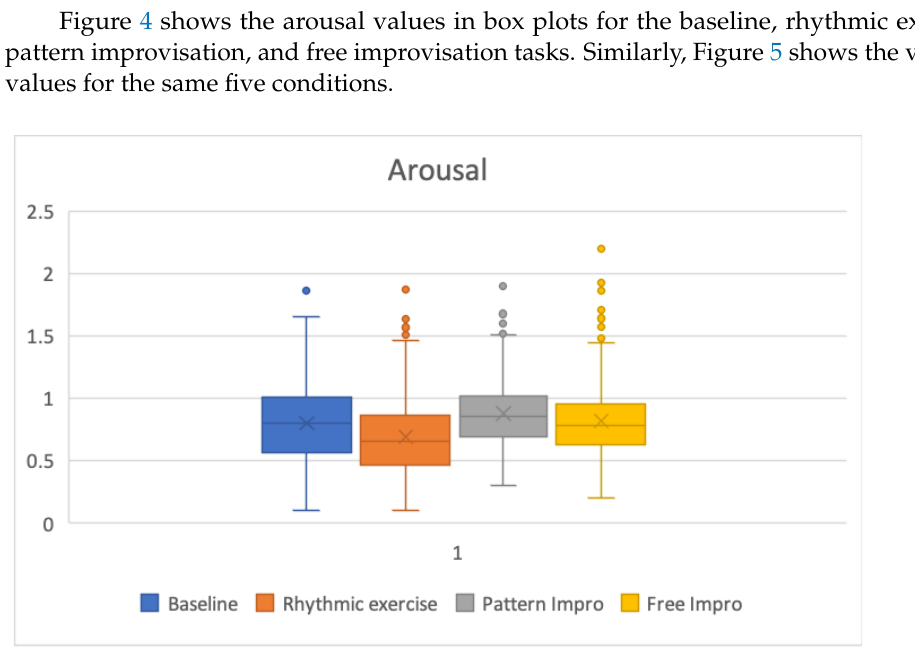
Figure 4. Box plot of the arousal values for the baseline, rhythmic exercise, pattern improvisation, and free improvisation tasks.